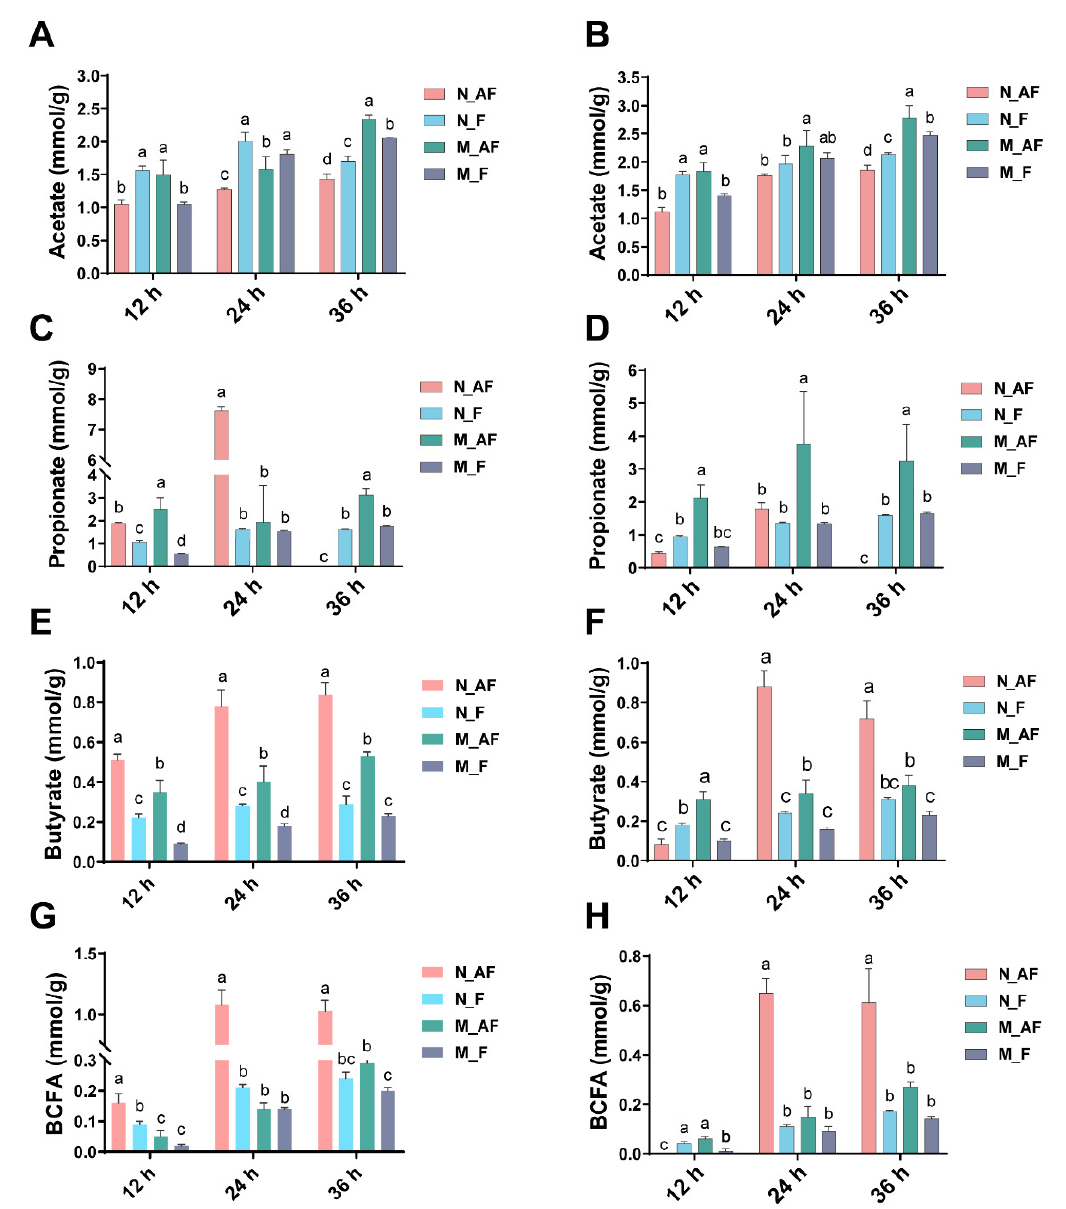
Figure 3. Changes of SCFAs production in the fermentation broth for digesta of Barley diet ( A , C , E , G ) and wheat shorts diet ( B , D , F , H ) at each sampling time during fermentation. The values were corrected for the amounts produced in the blank bottles and presented as the mean values. ( n = 4; Different letters mean p < 0.05; BCFAs were calculated as the sum of i-butyrate, n-valerate, and i-valerate). From the results of control groups (without substrates) at 24 h and 36 h during fermentation among different treatments (Figure 4), the concentration of propionic acid was much higher than that of other SCFA in the anti-frozen inoculum (N_AF or M_AF groups). Additionally, frozen inoculum with modified medium (M_F group) fermentation produced lower SCFA than other treatment